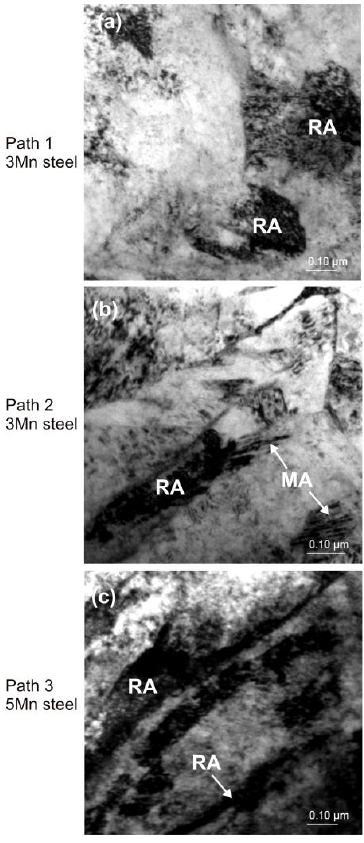
Figure 13. Transmission electron microscopy (TEM) micrographs showing the morphology of retained austenite and bainitic matrix in the: ( a ) 3 Mn steel (Path 1); ( b ) 3 Mn steel (Path 2); ( c ) 5 Mn steel (Path 3); RA—retained austenite, MA—martensite-austenite constituents.